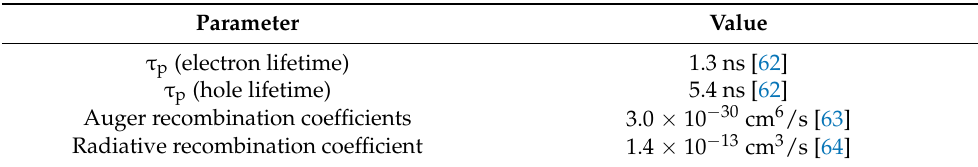
Table 2. Recombination parameters.